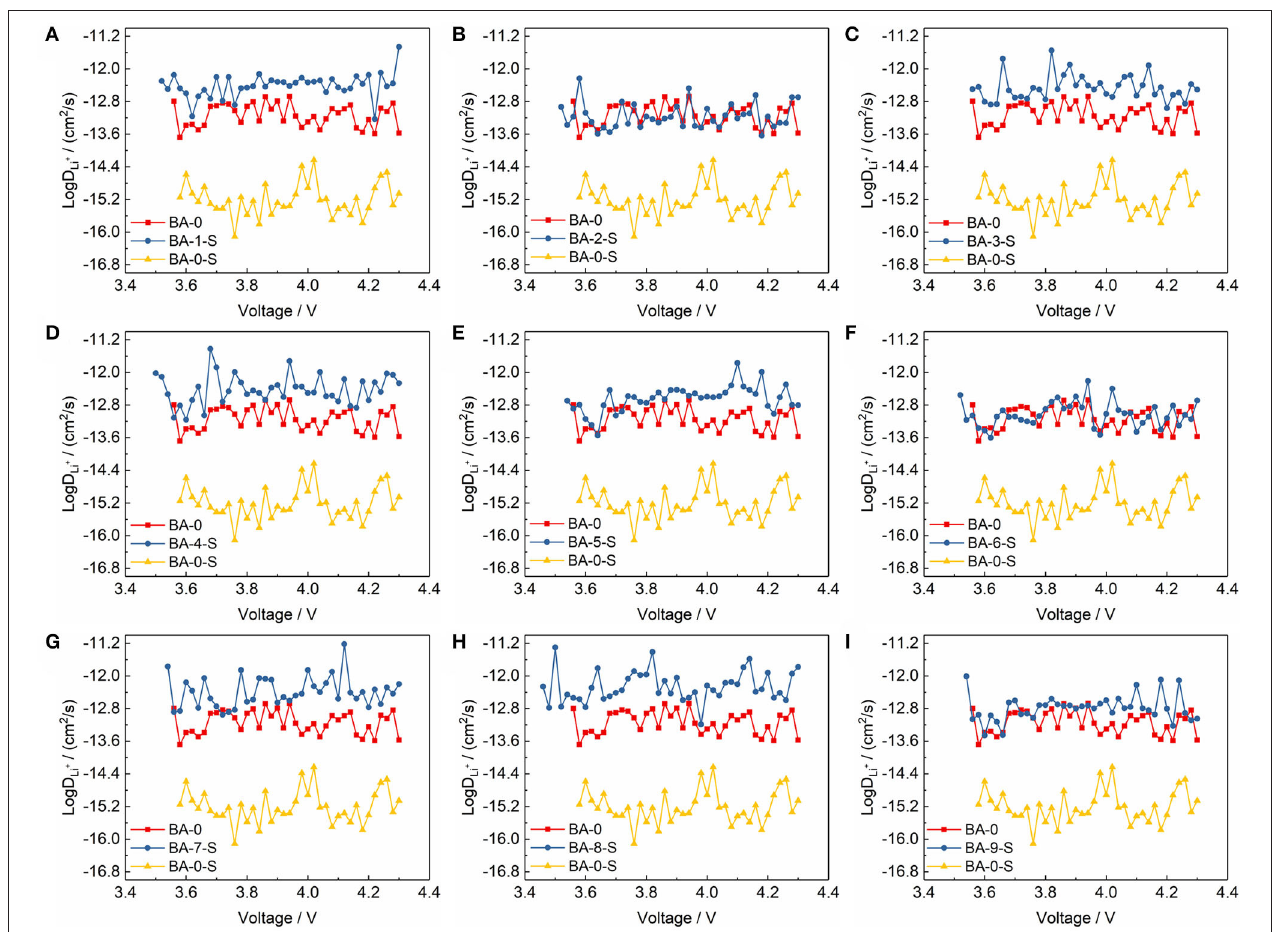
FIGURE 7 | The comparisons of Li + diffusion coefficients of (A–I) BA-1-S to BA-9-S with BA-0 and